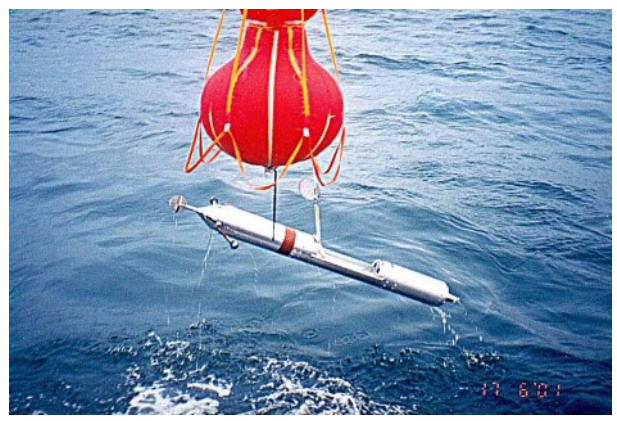
Figure 3. Recovery